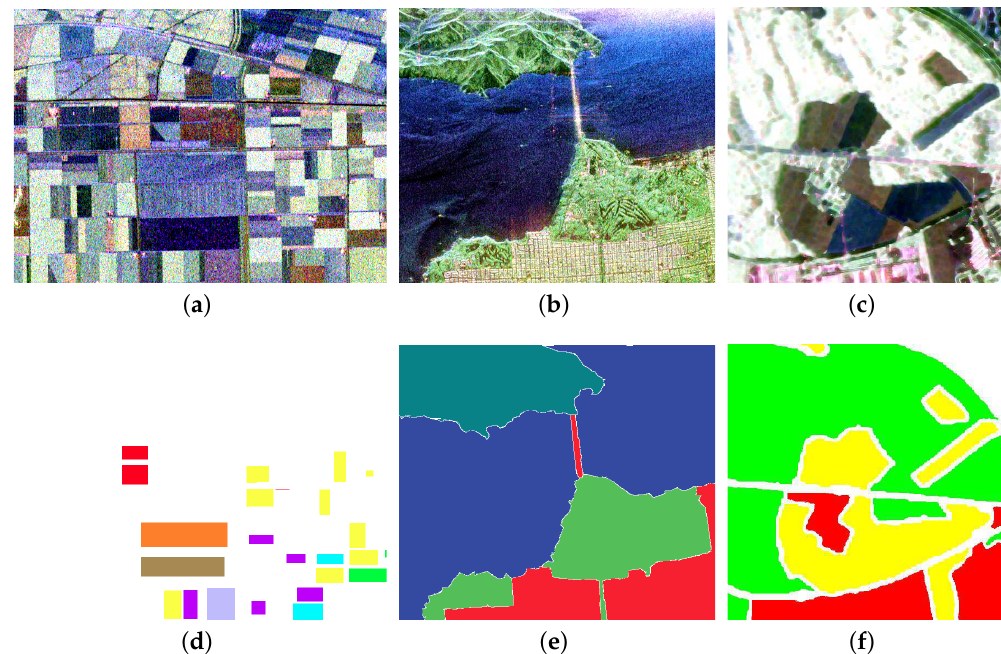
Figure 7. ( a ) The selected local region of Flevoland data set. ( b ) The selected local region of San Francisco data set. ( c ) The selected local region of Oberpfaffenhofen data set. ( d ) The ground truth of ( a ). ( e ) The ground truth of ( b ). ( f ) The ground truth of ( c